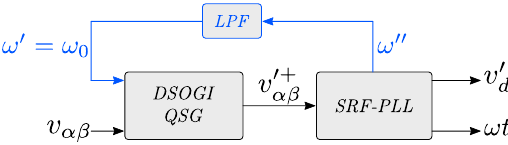
Figure 5. DSOGI-PLL with LPF block diagram.